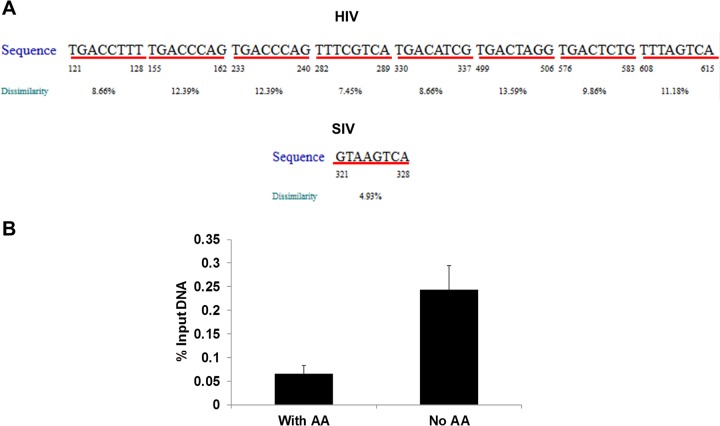
ATF4 is recruited to HIV LTR following amino acid deficiency. (A) Potential CREB/ATF binding sites identified in the HIV (top) and SIV LTR (bottom) region using PROMO software. The underlined sequence is the potential ATF4 binding site in the viral LTR. (B) ATF4 is recruited to HIV LTR after amino acid depletion. J-Lat cells were cultured in medium without amino acids (AA) for 18 h, and ChIP assays were performed with anti-ATF4 antibodies and analyzed by SYBR-qPCR with PCR primers targeting HIV LTR. Fold change of ATF4 binding to HIV LTR was calculated after being normalized to control treatment. *, P < 0.05. Experiments were performed three times.